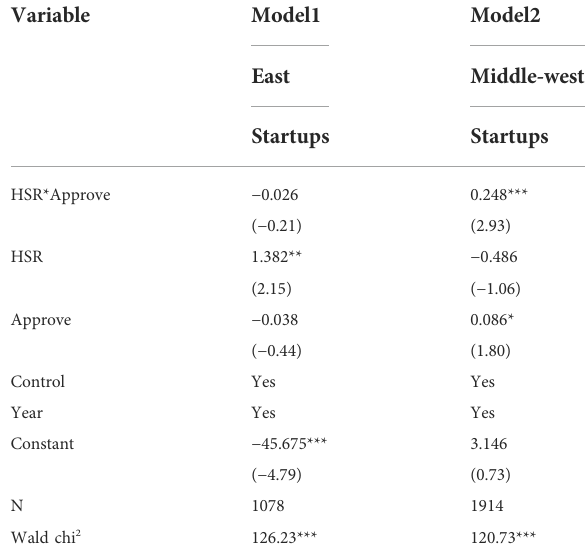
TABLE 8 Robustness check: Moderating effect.